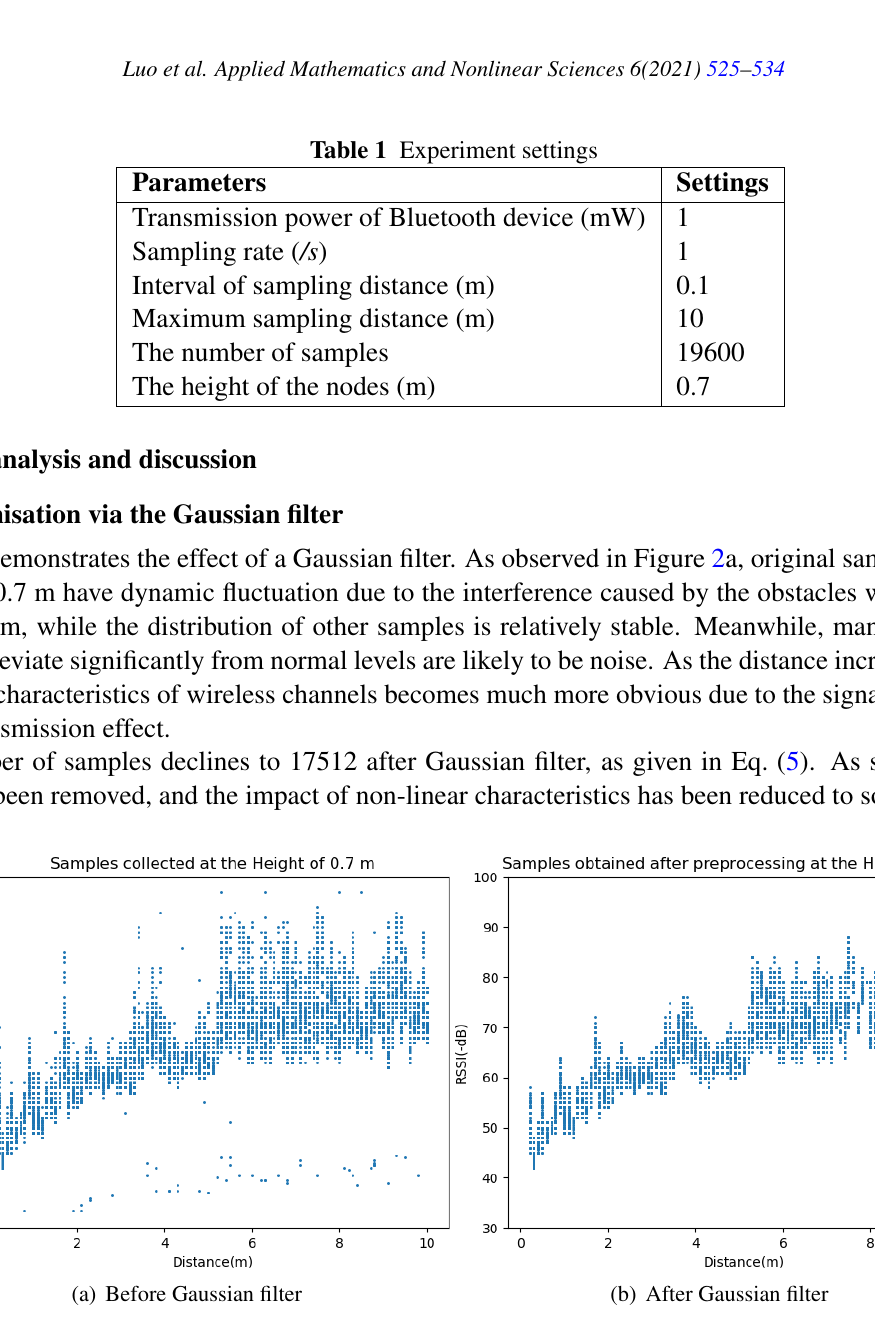
Fig. 2 Comparison of samples before and after Gaussian